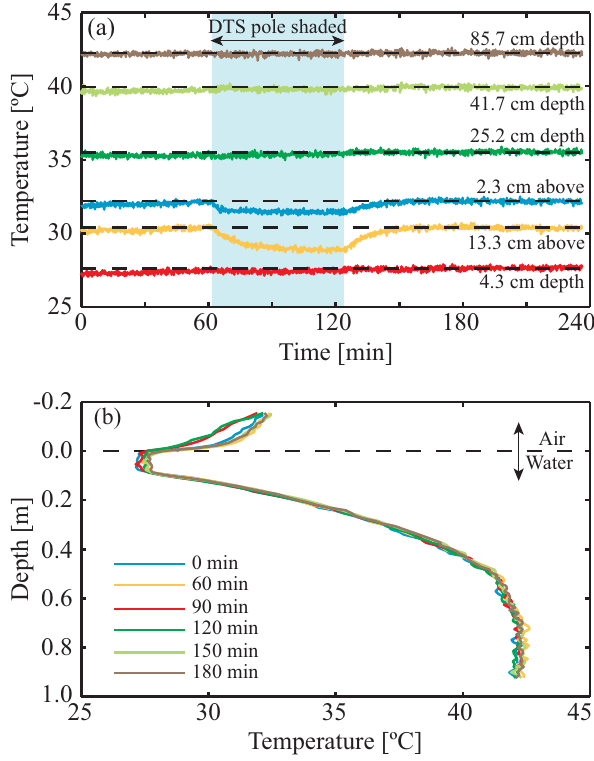
Fig. 6. Assessment of radiative heating of the DTS pole. (a) Ther- mal evolution at different depths in the water column and in the air. (b) Temperature profile measured with the DTS system at different times of the experiment. These measurements were obtained using a 10-s integration-time interval and using the manufacturer-internal calibration